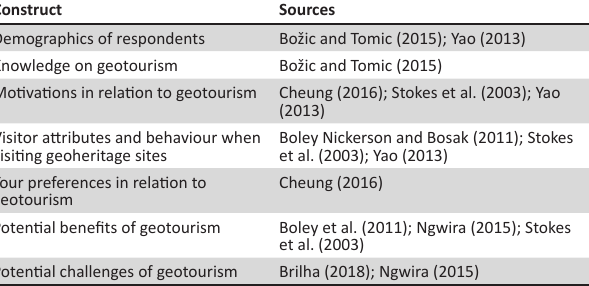
TABLE 1: Survey constructs and authors.